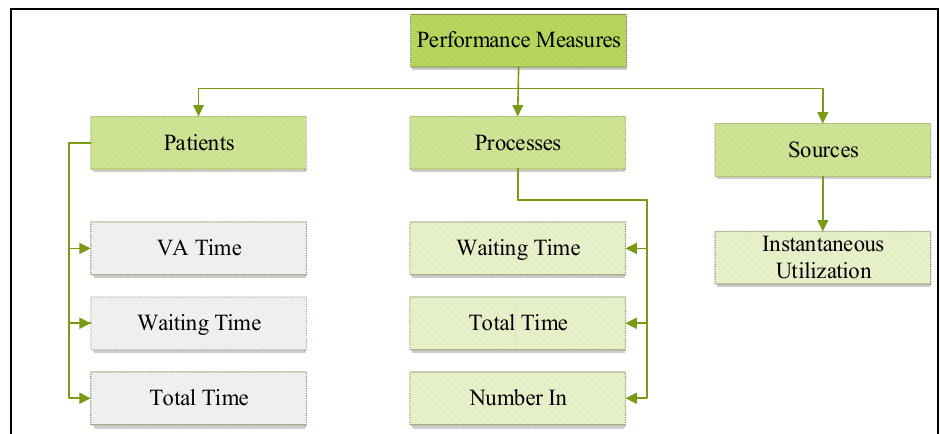
Figure 8. The performance measure for the current state performance evaluation .